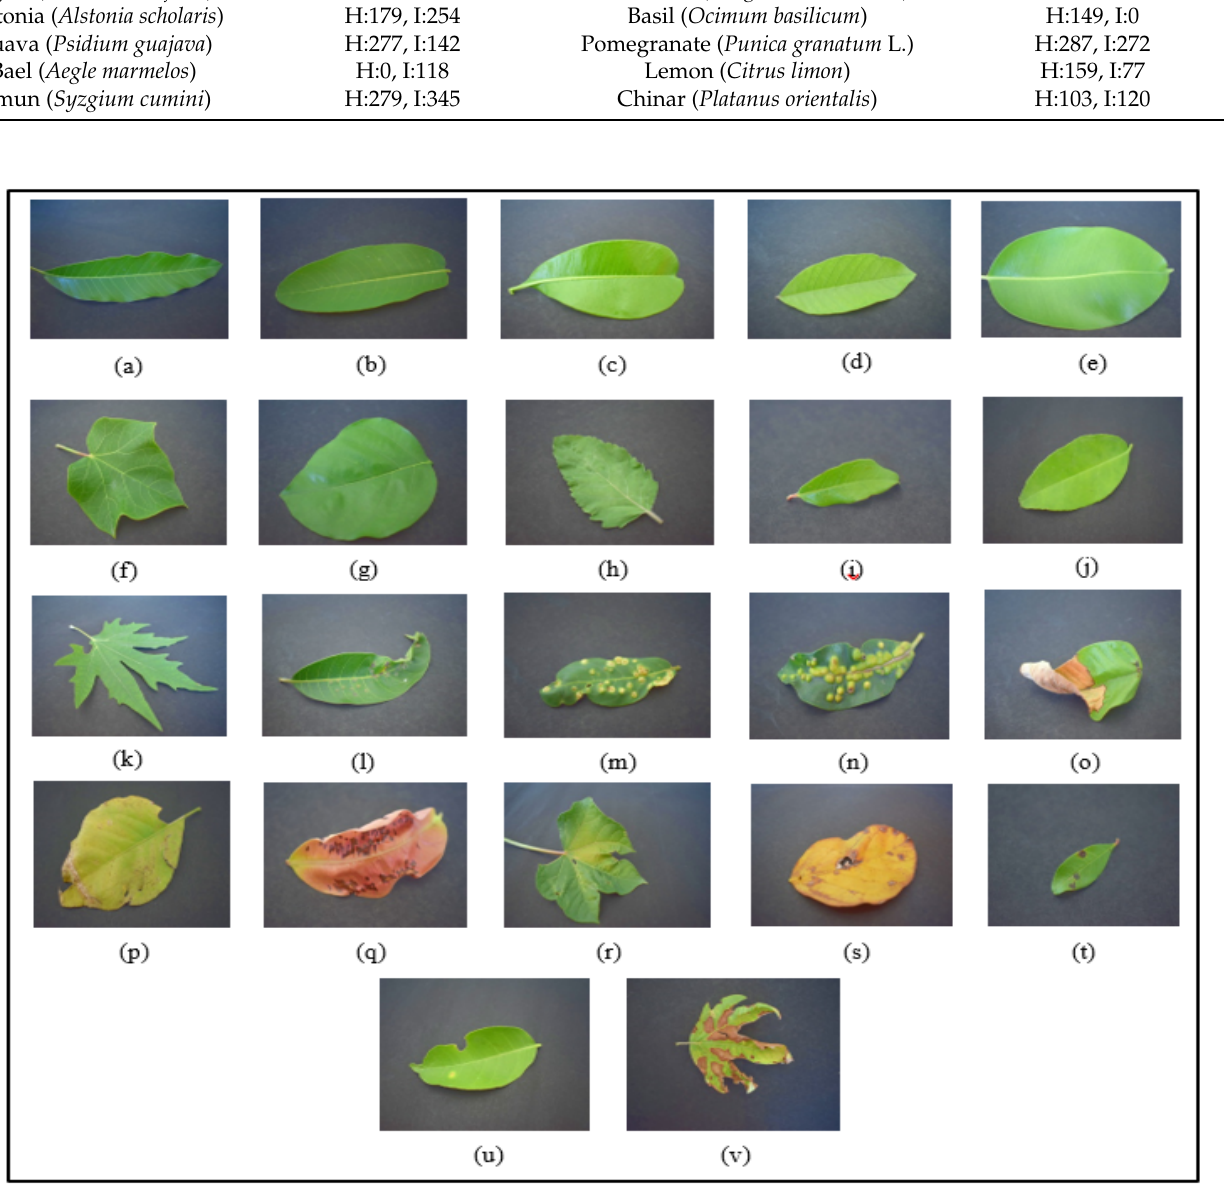
Healthy leaf sample and D indicates Diseased